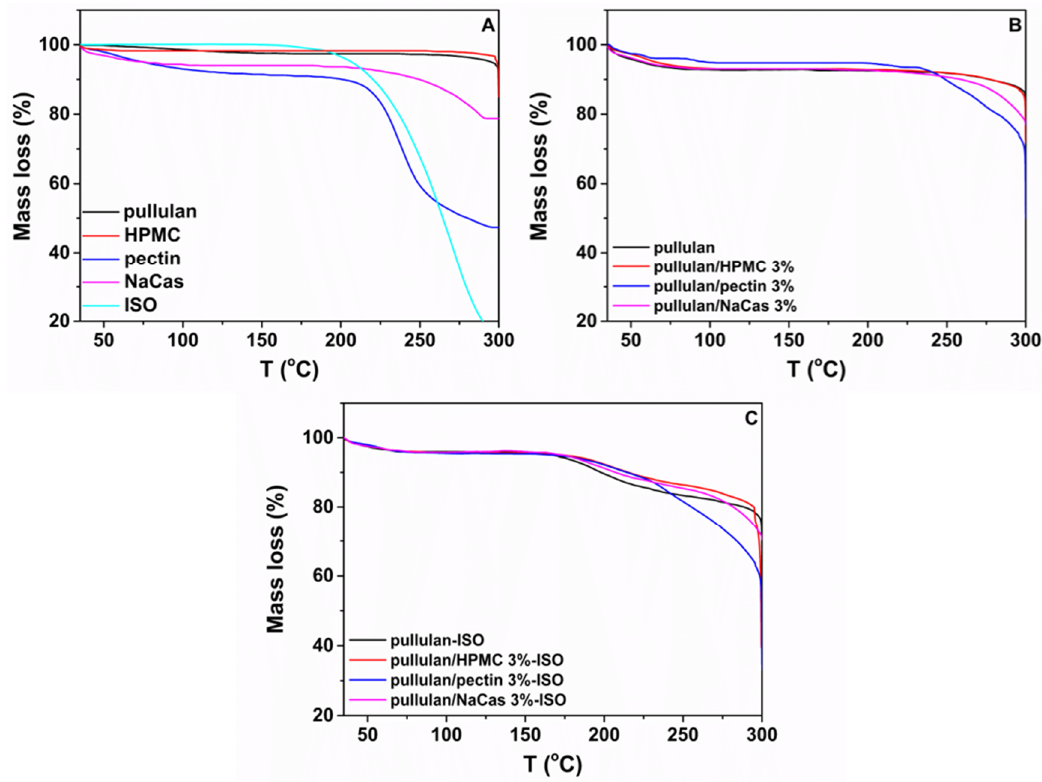
Figure 4. TGA curves of the ( A ) raw materials, ( B ) plain ODFs and ( C ) ISO-loaded